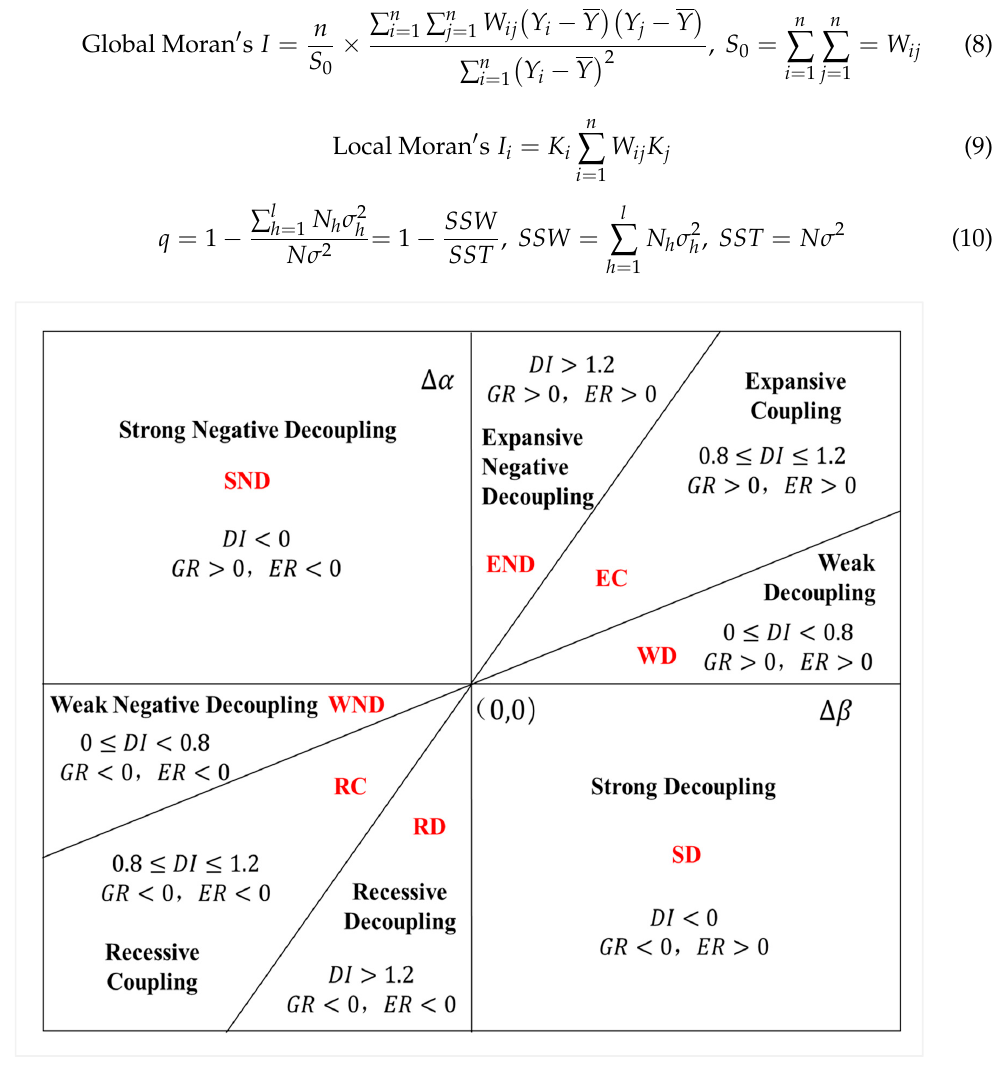
Figure 3. Decoupling